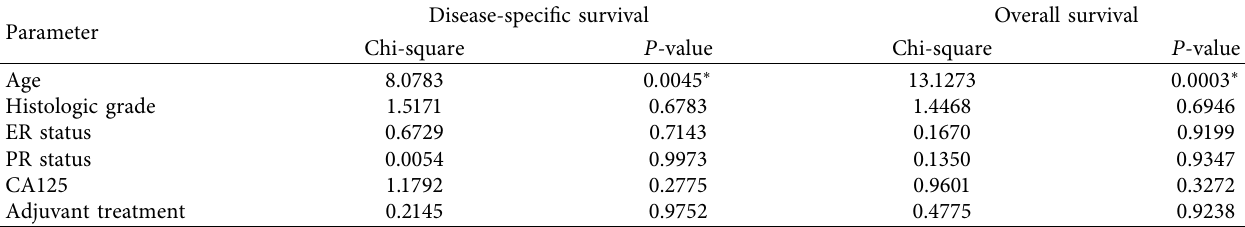
Table 2: Univariate analysis for risk factors afecting the survival status of women with stage I endometrial cancer.